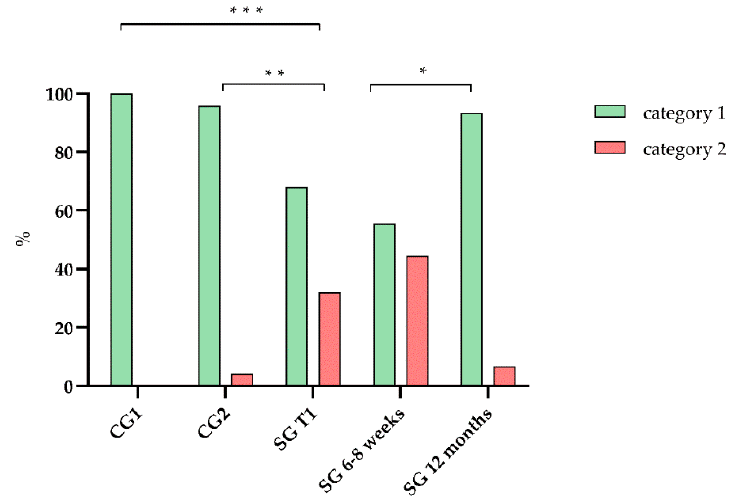
Figure 3. NRS (Nutritional Risk Screening 2002) categories of CG 1, CG 2 and SG at different time points. Category 1: well-nourished (NRS score < 3) and category 2: nutritionally at risk (NRS score